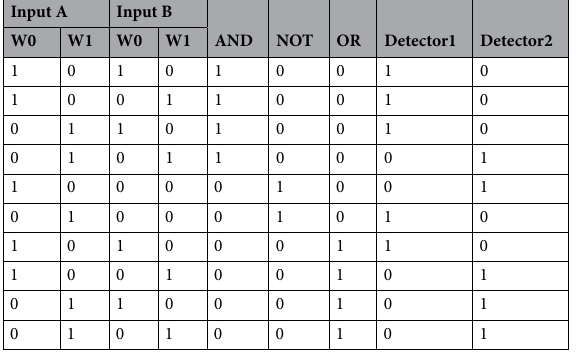
Table 1. The optical I/O table for optical logic gate operations performed by diffractive optical neural network